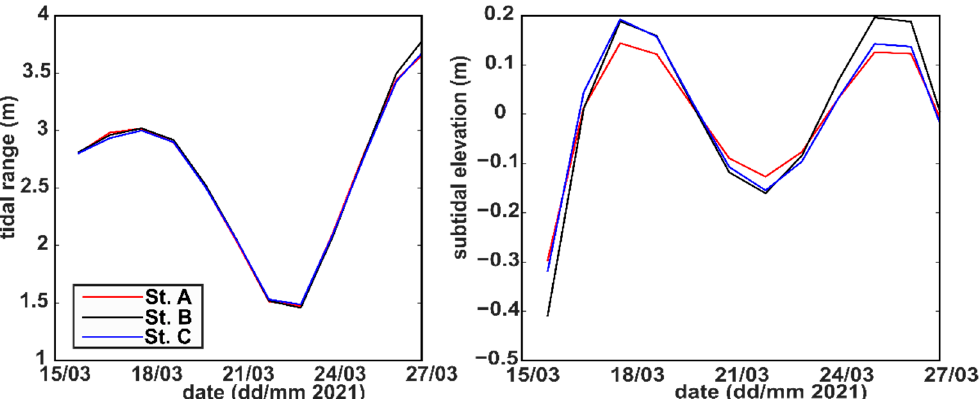
Figure 3. Tidal ranges ( left ) and subtidal elevations ( right ) at Stations A, B, and C.